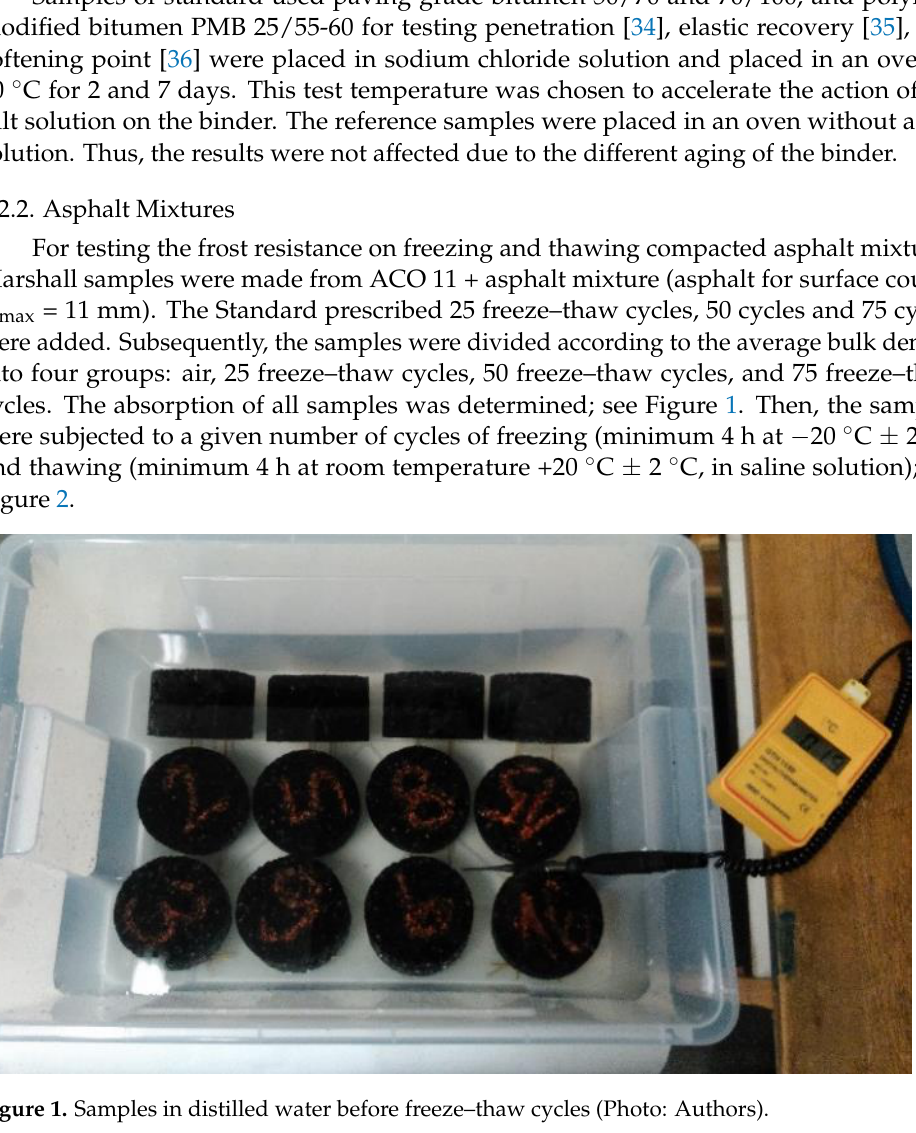
Figure 2. Freeze – thaw cycles (Photo: Authors). 2.2.3. Saline Solution According to CSN 73 6161 — Annex B [29], a saline solution in a concentration of 20 g/L was produced. The solution was made from distilled water and de-icing salt. It is a solid, odorless, white crystalline substance — sodium chloride NaCl, intended for winter maintenance but also direct consumption in the food industry. It is not a dangerous chem- ical. It is a commonly used as standardized sprinkling salt in the territory of the Slovak Republic and the Czech Republic. Its basic properties are listed in Table 4. Table 4. De-icing salt properties [37]. Physical and Chemical Properties